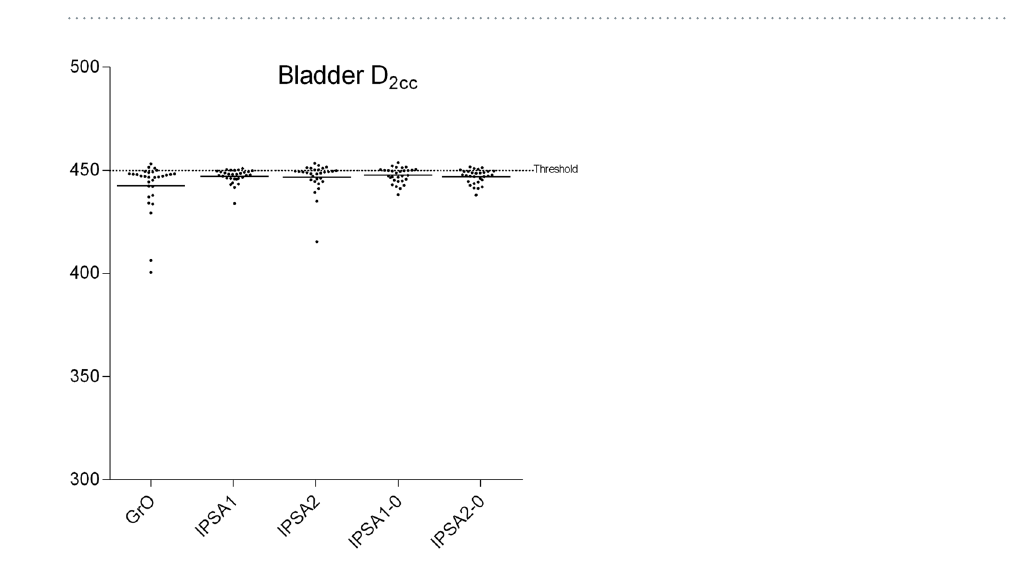
Figure 2. Linear relationship among D 90 , V 150 and V 200 .